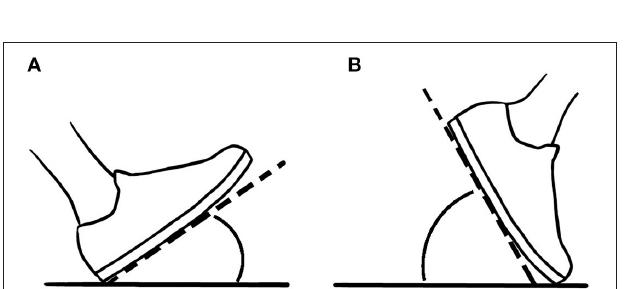
FIGURE 4 | Illustration of (A) heel strike angle and (B) toe-off angle. The heel strike angle is the angle between the ground and the foot when the heel landed on the ground at the beginning of the stance phase. The toe-off angle is the angle between the foot and the ground when the toes come off at the end of the stance phase.